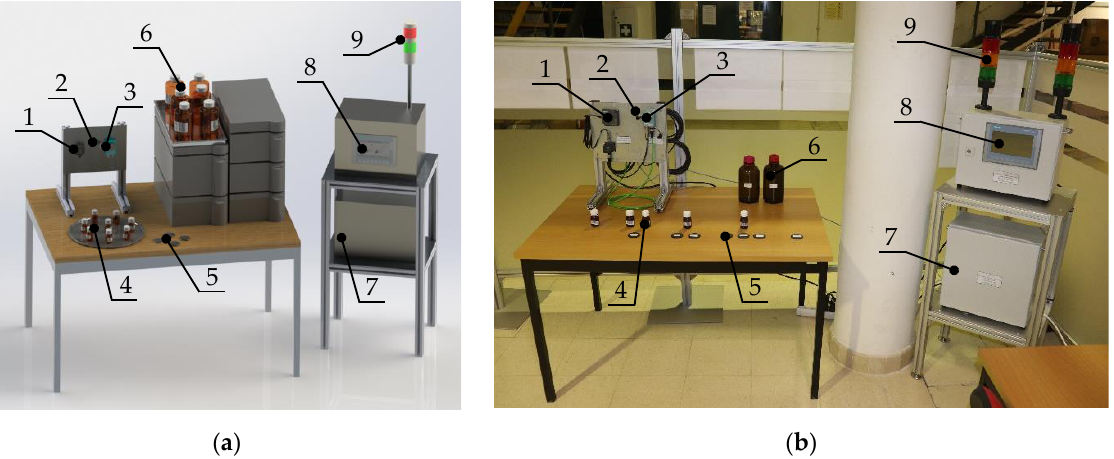
Figure 5. PLC Platform components: ( a ) Prototype; ( b ) Implementation.